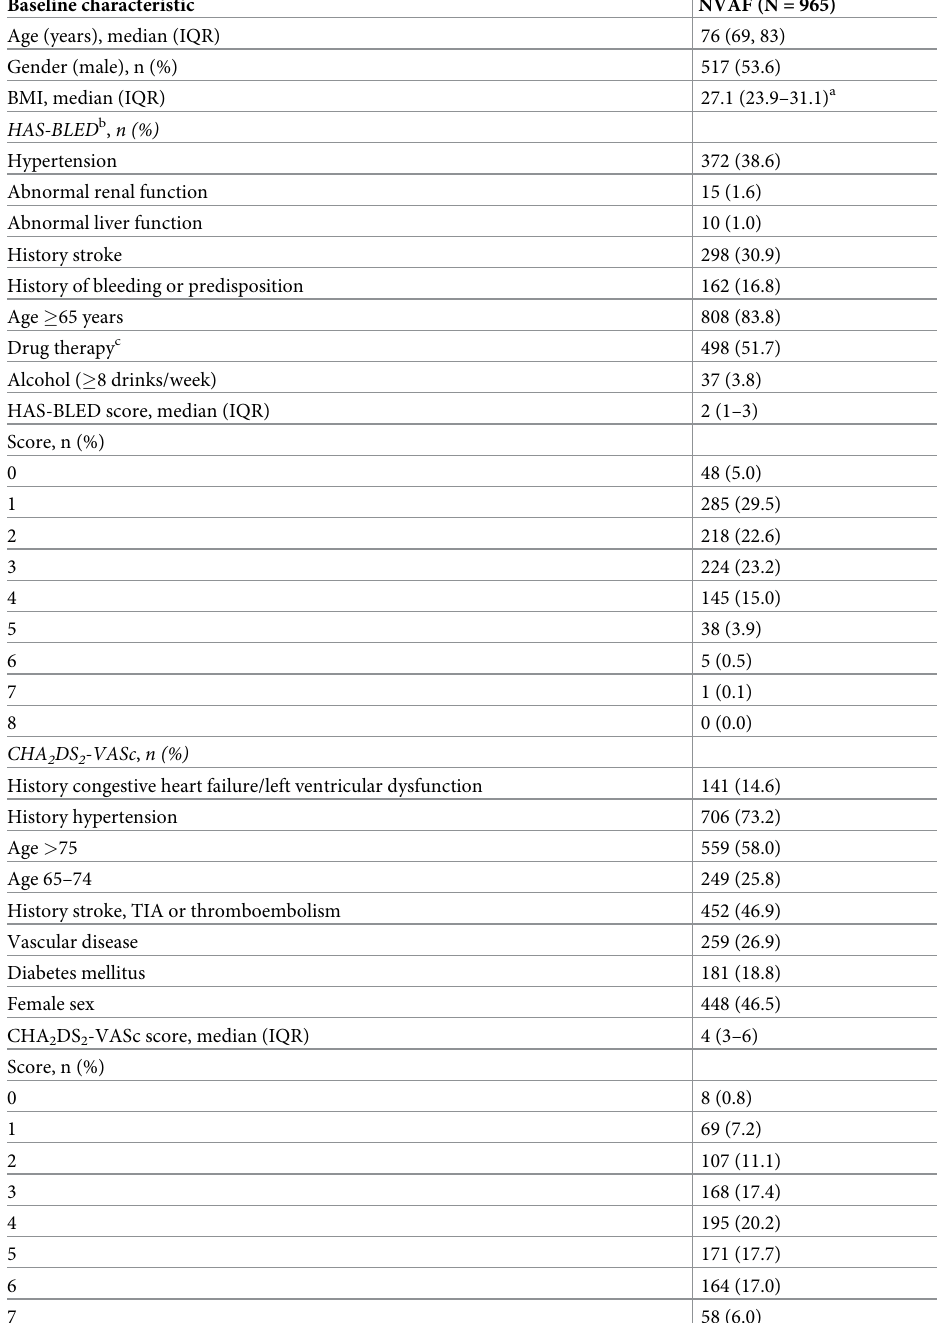
Table 1. Baseline characteristics and posology of